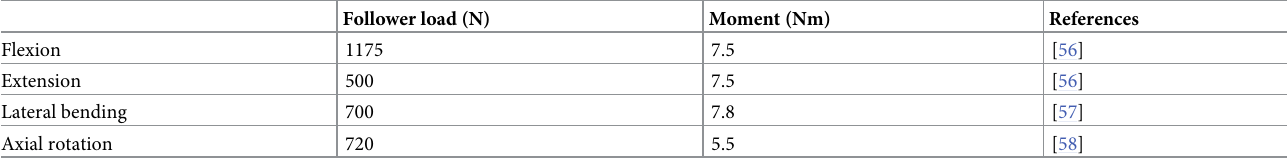
Table 2. Loading and moment conditions of four lumbar spine